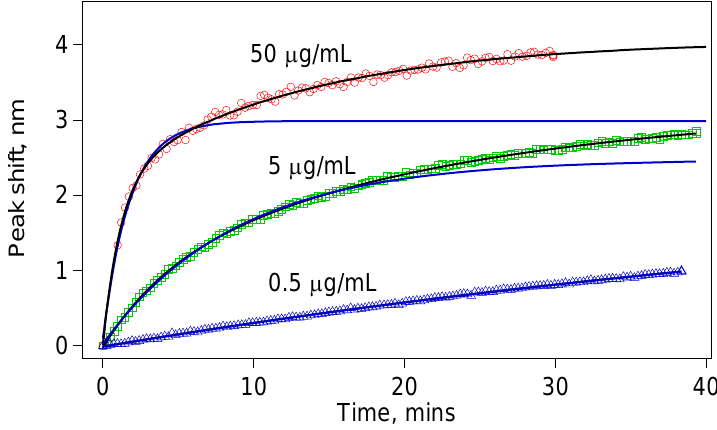
Figure 8. The data for the tapered fiber sensors do not fit to a simple exponential (blue solid curves). They rather fit to a double exponential indicating two rate constants. This behavior is especially clear with higher